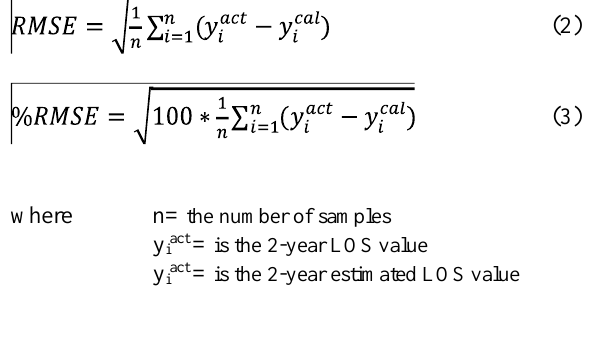
Figure 3. PSI deformation velocity map.